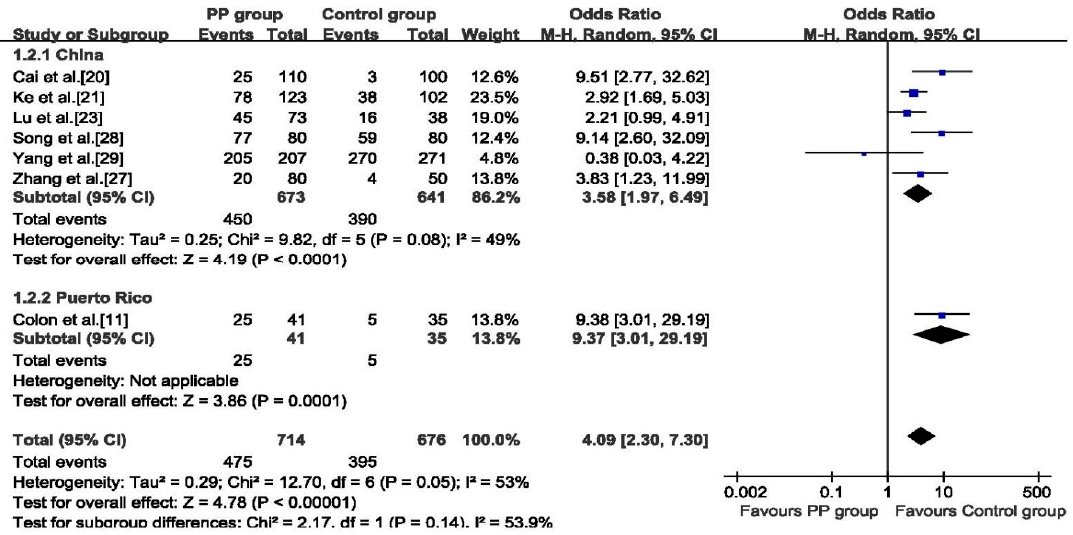
Figure 2. Forest plot for the association between serum DEHP and PP.